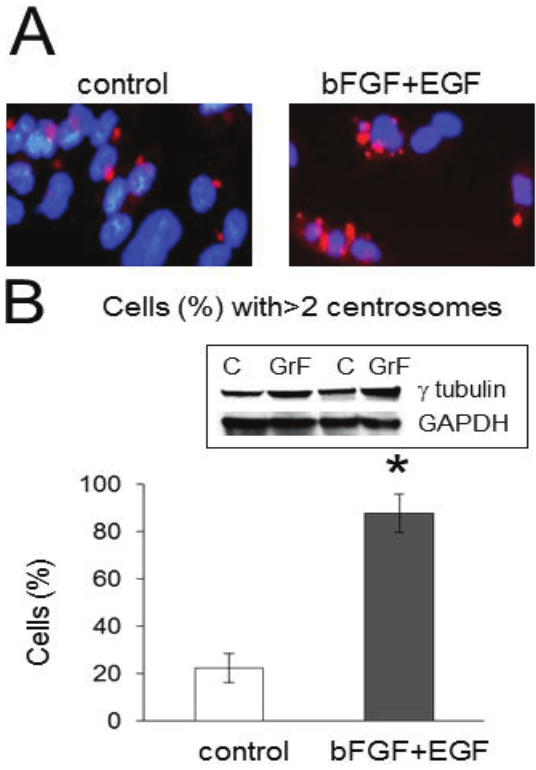
Figure 1. Stimulation with growth factors induces centrosome amplification in U251 cells. ( A ) Examples of centrosomes marked with the PACT domain of pericentrin attached to the red fluorescence protein (PACT-mKO1) in clones of U251 cells in control (unstimulated) or stimulated with growth factors (EGF, 40 nM and bFGF 40 nM). There is amplification of centrosomes in cells treated with growth factors compared to the control. Nuclei were stained with DAPI. ( B ) The graph represents the averaged percentages of cells with amplified centrosome number following stimulation with growth factors (87% ± 8%) versus control (22% ± 6%). The difference is significant with p = 0.0008. The experiments were performed four times. The insert illustrates the total level of (cid:2)-tubulin values in cells non-treated (C) and treated with growth factors (GrF). Note that growth factor treatment induced an increase of (cid:2)-tubulin/GAPDH ratio (by 44% and 57% in two illustrated experiments in Western blot). The increase is significant (50% ± 7%, p = 0.005, three